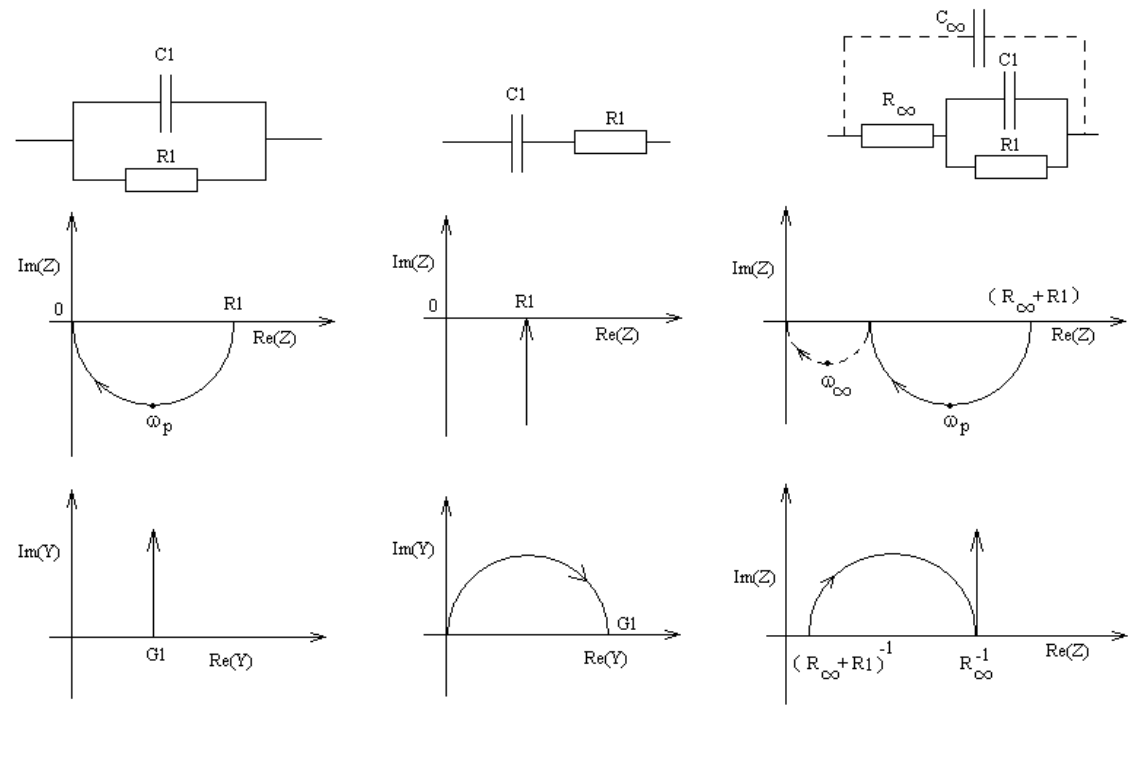
Fig. 6: Typical models with impedances and admittances in the complex plane. Semicircles of impedance denote parallel connection of a capacitor and resistor while semicircle of the admittance denotes series connection.